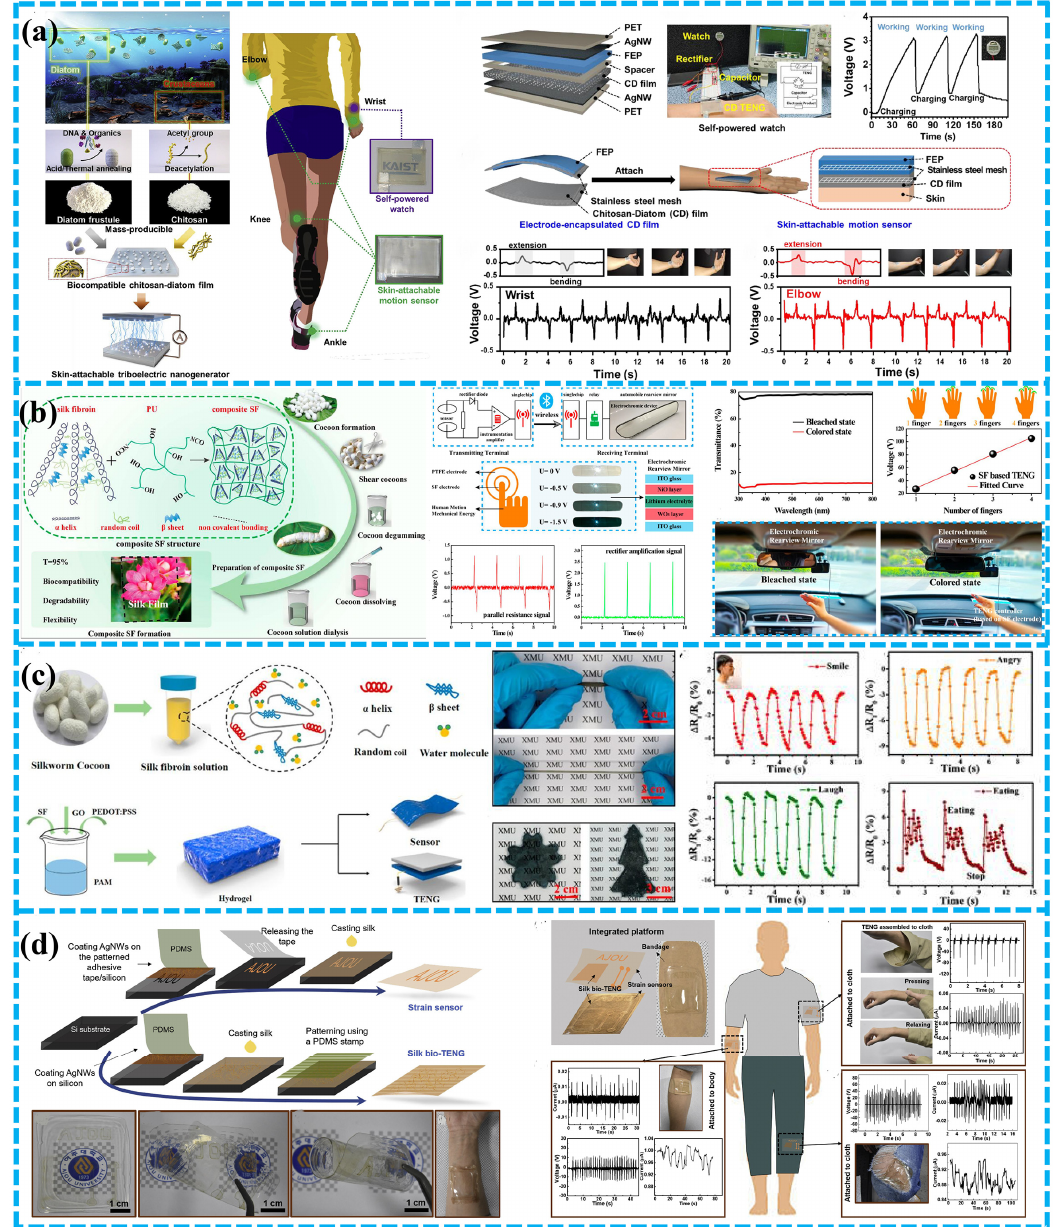
Figure 9. BD-TENGs based on animal extracts for self-powered active sensing system. ( a ) A skin adherent and bio-friendly chitosan diatom-based TENG; synthesis of mass-producible diatom frus- tule and chitosan from naturally abundant ocean biomaterials and biocompatible chitosan-diatom triboelectric nanogenerator; applications of chitosan-diatom TENGs to wearable devices operated from human motion. Reproduced with permission [103], Copyright 2020, Elsevier Ltd. ( b ) A TENG for SF, which can be stretched, stabilized, and degradable through mesoscopic doping, is used to adjust the color/transmissivity triggered by finger movement and harvest biomechanical energy in vitro or in vivo for intelligent wireless communication. Reproduced with permission [110], Copy- right 2021, American Chemical Society. ( c ) A stretchable, biocompatible, and multifunctional SF hydrogel for wearable strain/pressure sensors and TENG; application of the PSGP sensor for moni- toring some body signals. Reproduced with permission [111], Copyright 2020, American Chemical Society. ( d ) A skin contact driven single electrode protein TENG and strain sensor for biomechanical energy harvesting and motion sensing; schematic diagram and photograph images of the integrated strain sensor and the bio-TENG on a bandage. Reproduced with permission [105], Copyright 2019, Elsevier